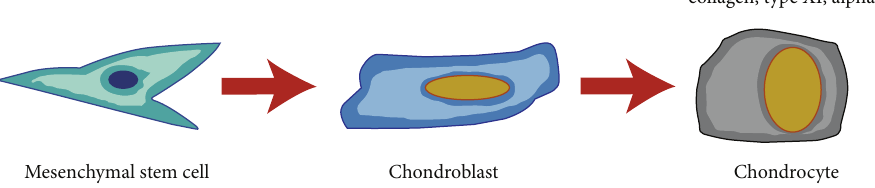
Figure 1: Chondrogenic differentiation and the way in which MSCs can contribute to articular cartilage